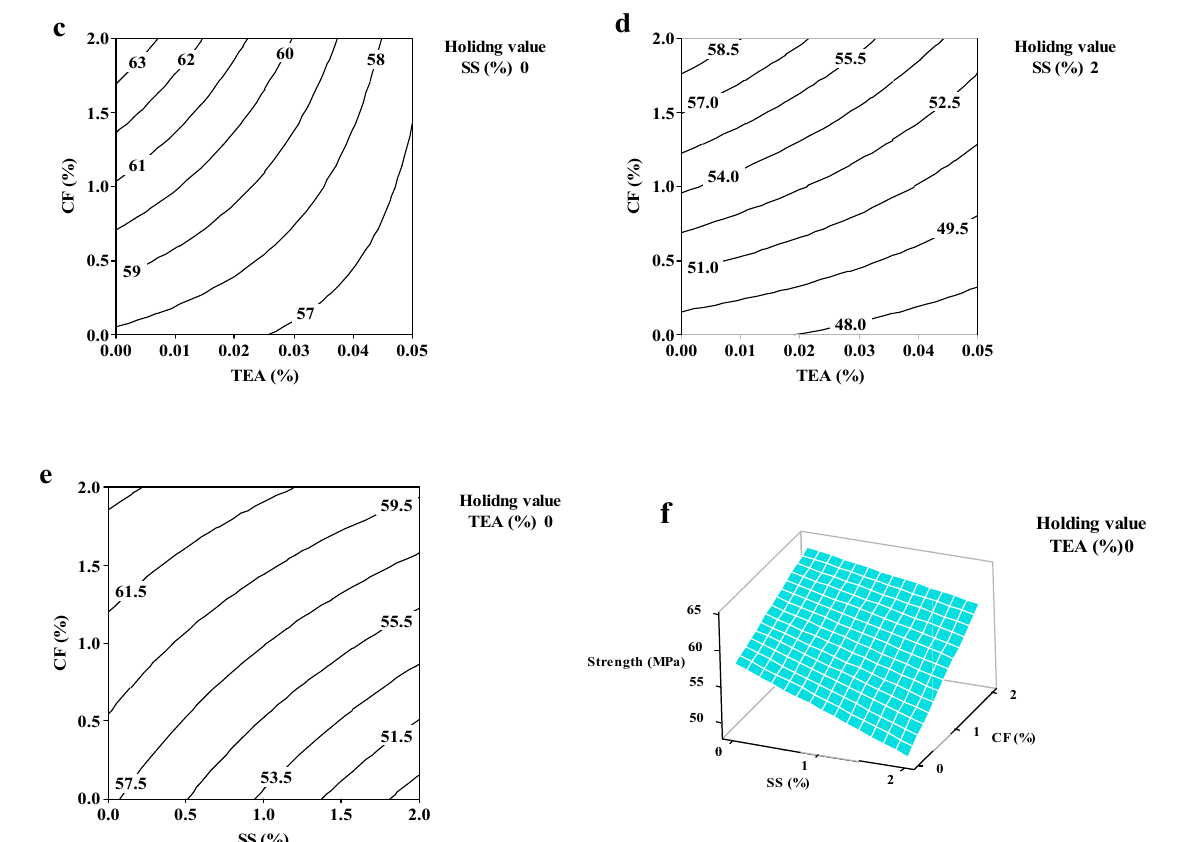
Figure 6. Effect of CF, TEA and SS on the 28 d strength of cement mortars: ( a ) SS vs. TEA (no CF), ( b ) SS vs. TEA (2% CF), ( c ) CF vs. TEA (no SS), ( d ) CF vs. TEA (2% SS), ( e ) CF vs. SS (2D contour plot), ( f ) CF vs. SS (3D contour